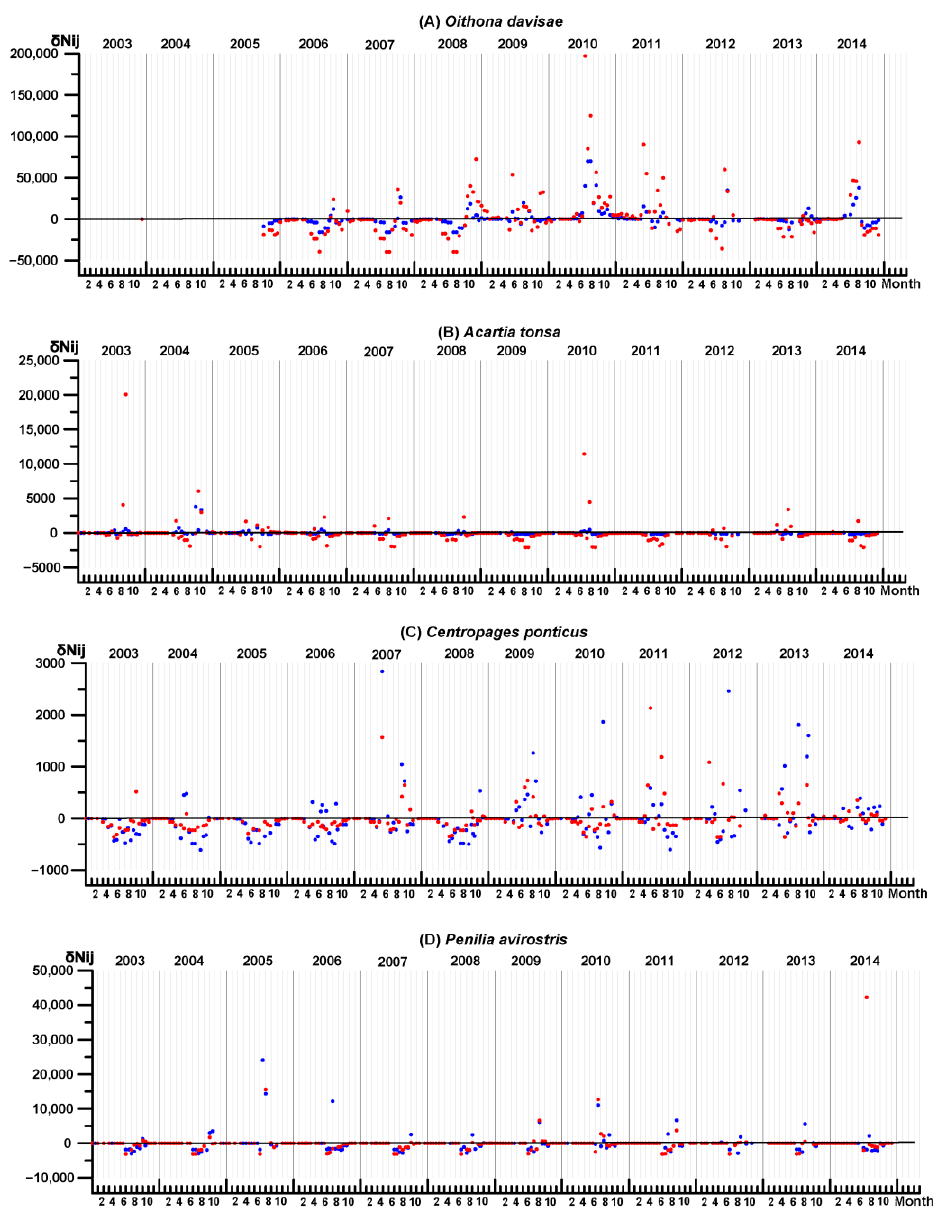
Figure 8. Long-term fluctuations in anomalies of warm-water crustaceans abundance relative to the annual variation (see details of the method in Section 2.4) in Sevastopol Bay at station 1 (blue) and station 2 (red): ( A )— Oithona davisae ; ( B )— Acartia tonsa ; ( C )— Centropages ponticus ; ( D )— Penilia avirostris .